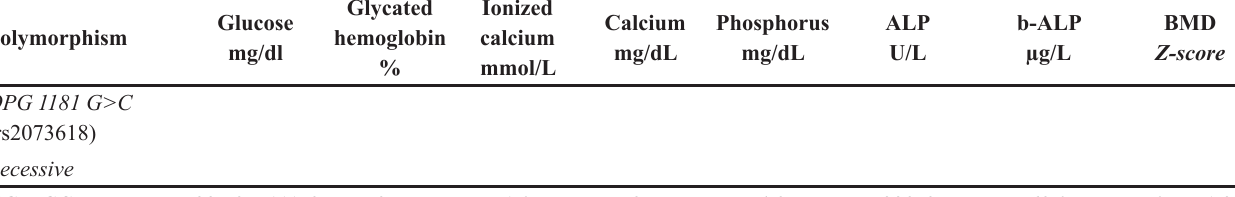
TABLE IV - Biochemical parameters according to studied polymorphism genotypes in patients with T1DM